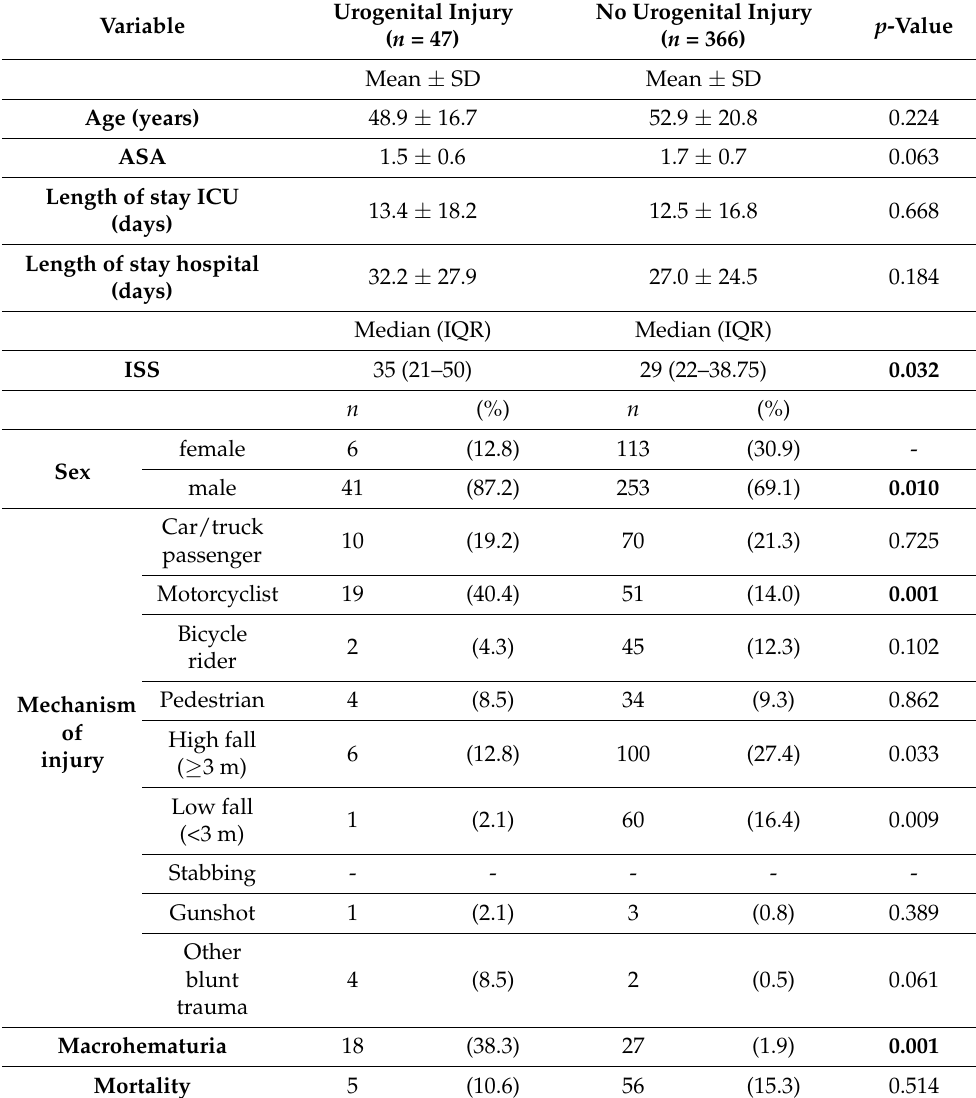
Table 2. Comparison of patient specific data and outcome parameters in the subgroups with and without urogenital